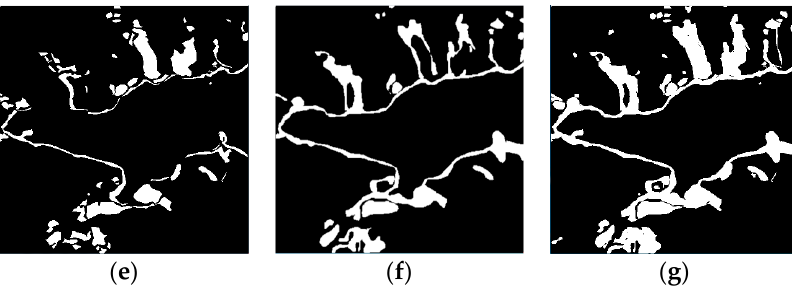
Figure 4. The Pauli-RGB images of LiangZi Lake after preprocessing on ( a ) 7 December 2011; ( b ) 25